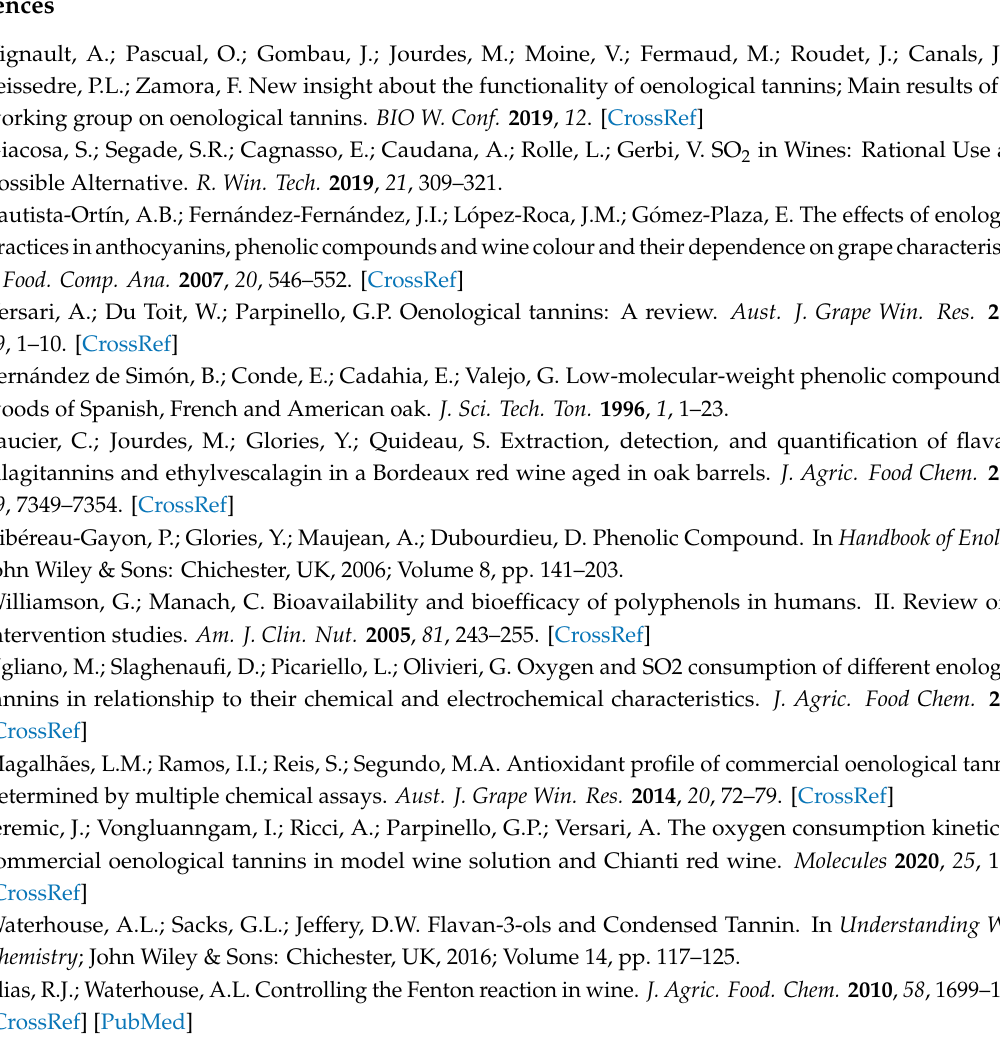
of the TT mixture acquired in the negative ione mode. Figure S3: 1 H-NMR spectrum in CD 3 OD of the CT mixture. Figure S4: Enlargements of the HR-ESIMS spectrum of the CT mixture acquired in the negative ione mode. Figure S5: 1 H-NMR spectrum in CD 3 OD of the ET mixture. Figure S6: Enlargements of the HR-ESIMS spectrum of the ET mixture acquired in the negative ione mode. Figure S7: 1 H-NMR spectrum in CD 3 OD of the GT mixture. Figure S8: HR-ESIMS spectrum of the GT mixture acquired in the negative ione